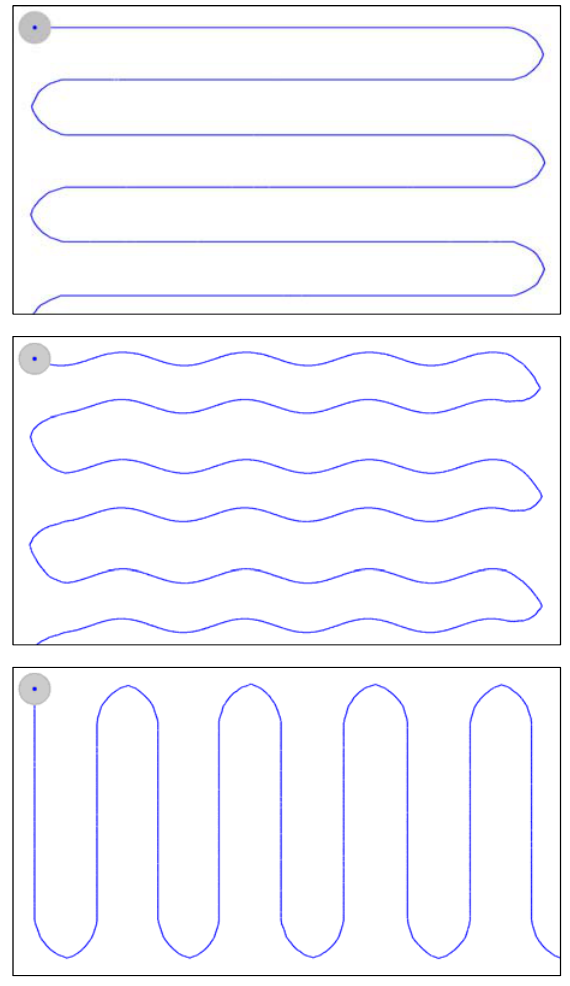
Figure 1. Trajectories of moving